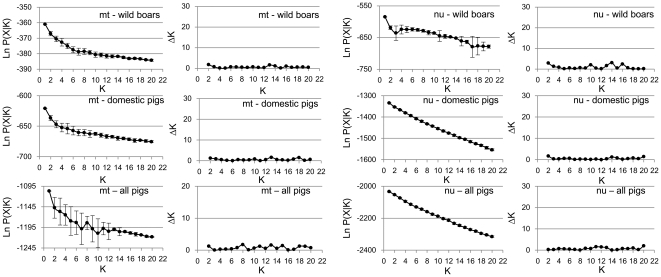
Bayesian clustering results.Plots of LnP(X|K) (±SD) and ΔK versus the number of K at D-loop (mt) or in multi locus (CH4, CH7, CH11, and CH14) nuclear DNA (nu) for wild boars, domestic pigs and both combined.